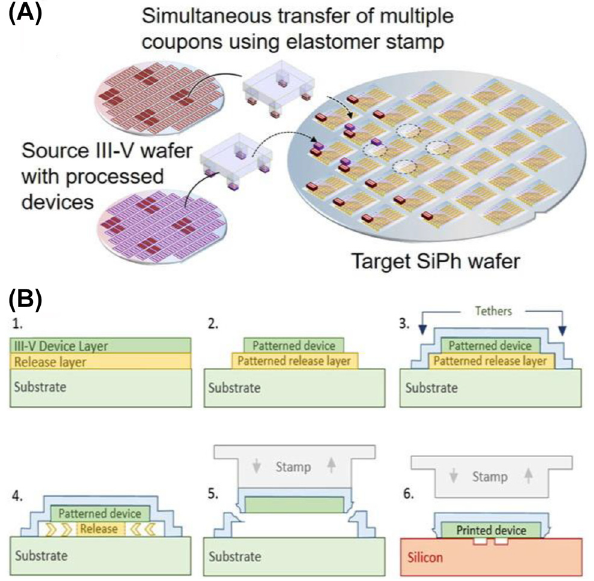
Figure 4: (A) μ TP-based integration on 200 or 300 mm Si photonic wafers in a parallel manner [60]. (B) Prefabrication of III–V devices on the native substrate and μ TP integration process